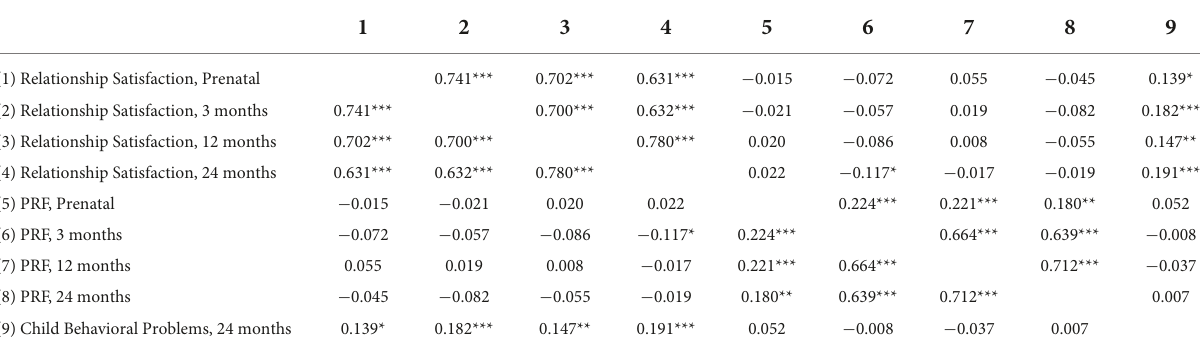
TABLE 5 Correlations between the study variables for